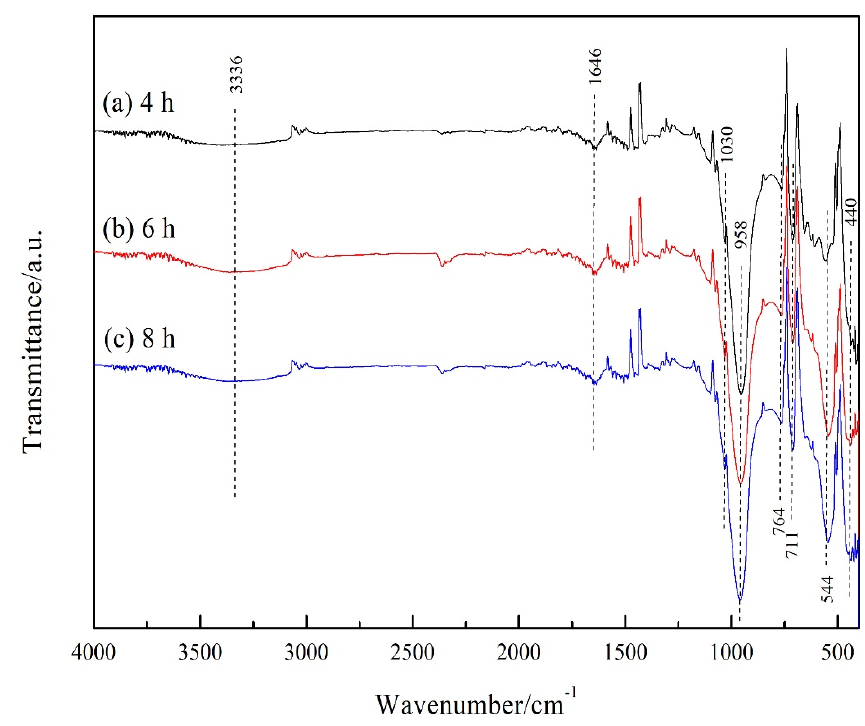
Figure 2. Fourier transform infrared (FT-IR) spectroscopy of the BFSZ prepared at various crystallization time.